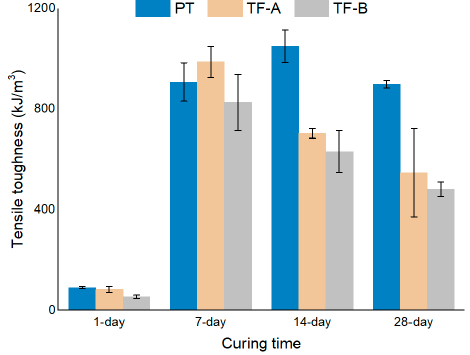
Figure 12. Comparison of tensile toughness at different curing.